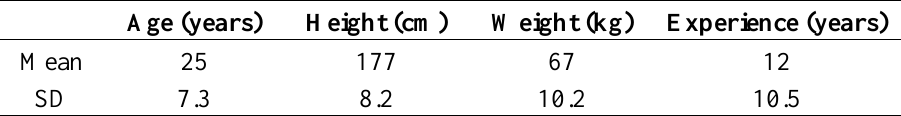
Table 1. Characteristics of participating